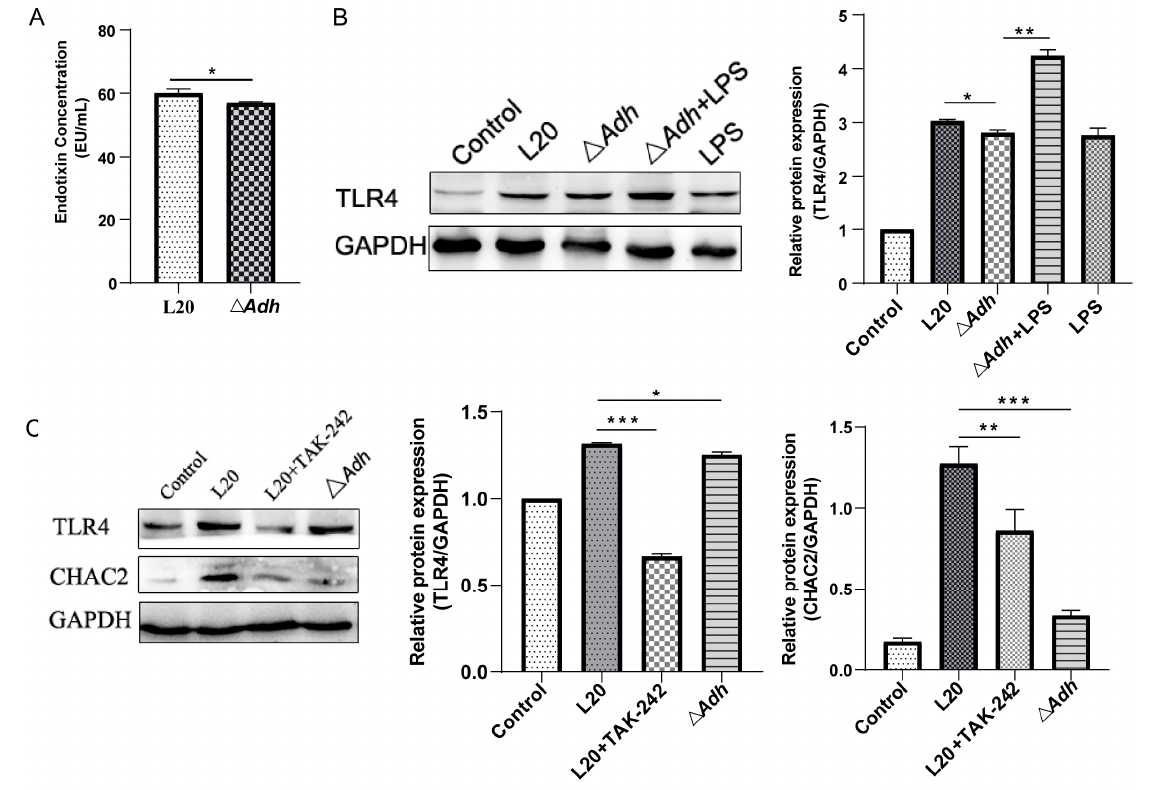
Figure 5. The effect of A. pleuropneumoniae ‘s LPS on the expression of TLR4 and CHAC2. ( A ) LPS detection in A. pleuropneumoniae strain L20 and Δ Adh . ( B , C ) The levels of ( B ) TLR4 and ( C ) CHAC2 were measured by Western blot analysis and ImageJ analysis. t -test and One-way ANOVA. * p < 0.05, ** p < 0.01, *** p < 0.001.